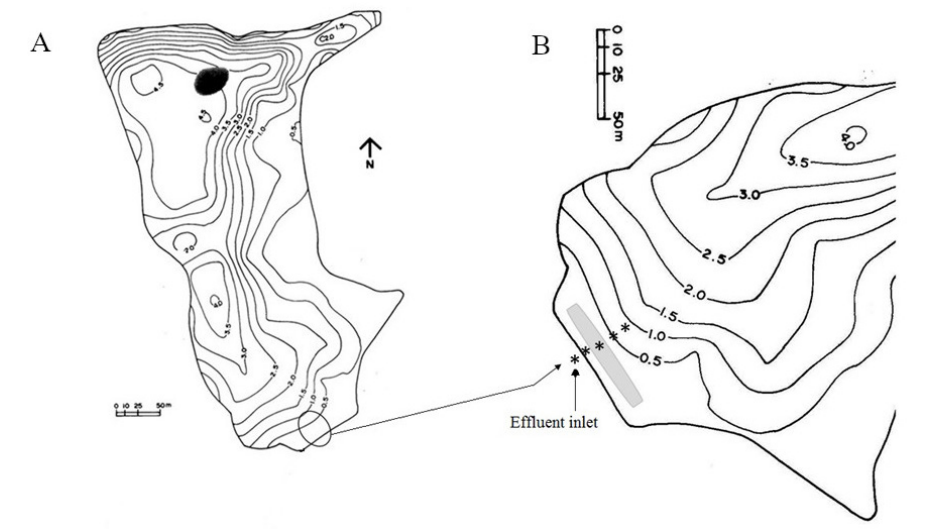
Figure 1. A. The location of the sampling area in the Garças Reservoir bathymetric map (B; Bicudo et al., 2002). B. Scheme showing the sequence of the sampling sites from the discharge of the effluent (effluent inlet; effluent path; inside macrophyte stand; after 1 m from the macrophyte stand; 10-15m away from the stand). The gray area represents the macrophyte